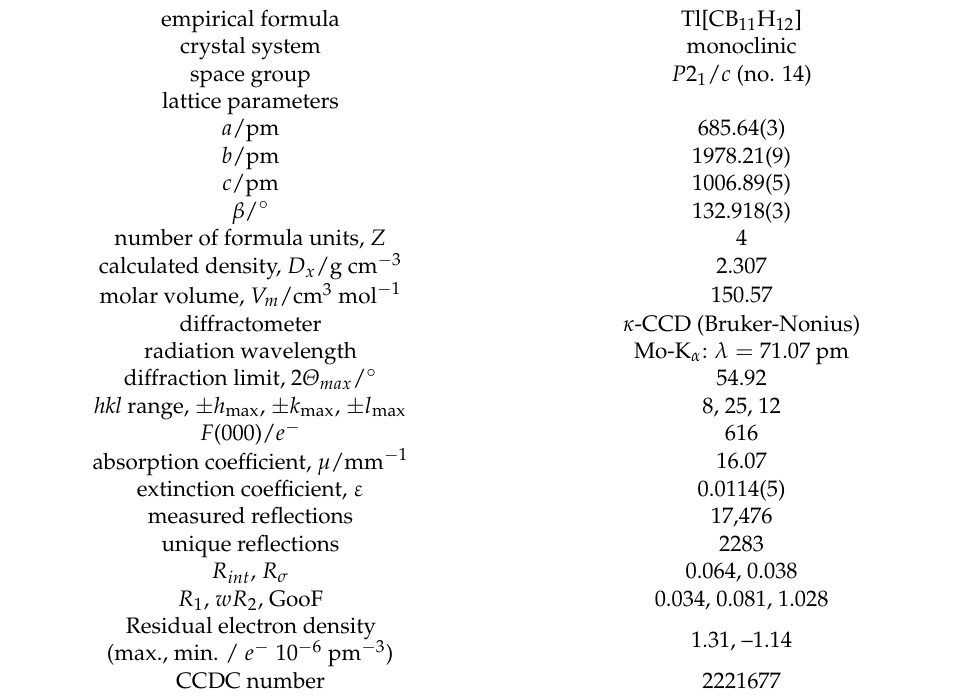
Table 1. Crystallographic data of Tl[CB 11 H 12 ] and their determination.